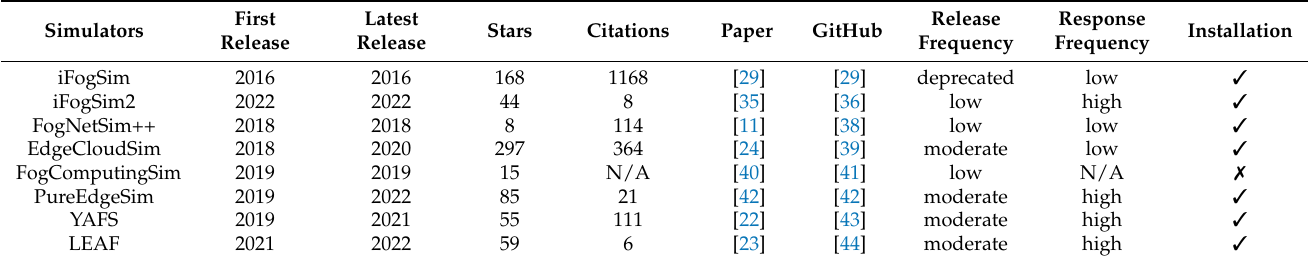
Table 2. Non-technical overview of simulators (Consulted on 15 June